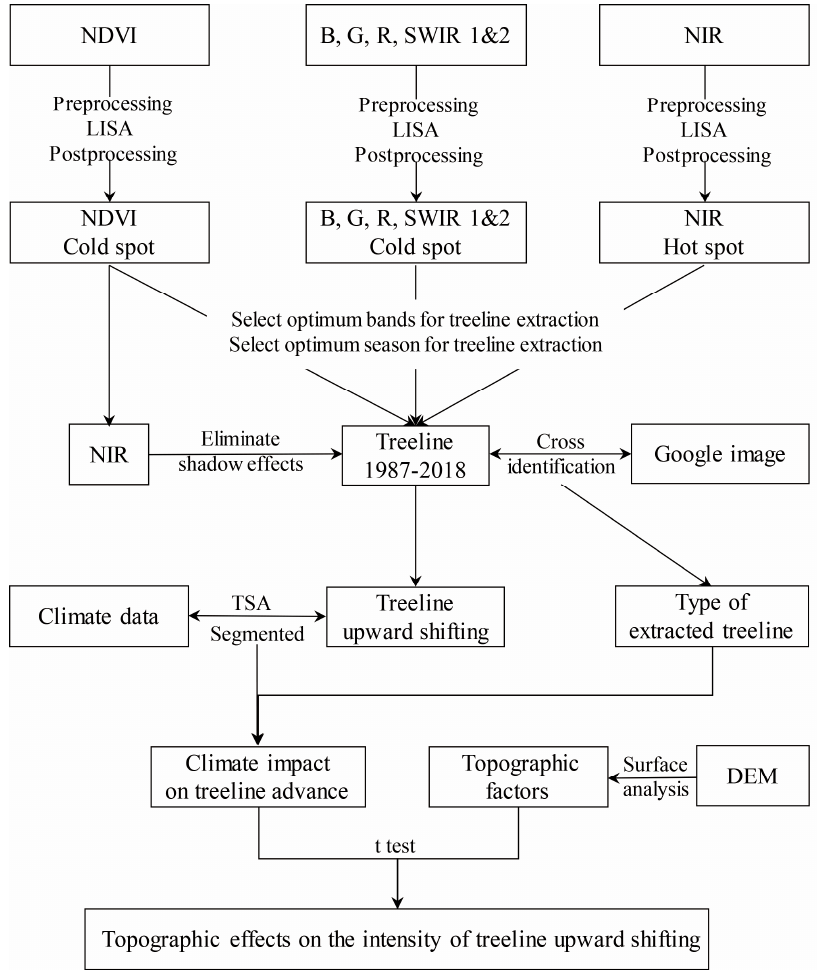
Figure 4. Methodology flowchart. TSA: time-series analysis; segmented: segmented linear regression; NDVI: normalized difference vegetation index; B: blue band; G: green band; R: red band; NIR: near-infrared band; SWIR 1 and 2: first and second shortwave infrared bands; DEM: digital elevation model image with a 30 × 30 m spatial resolution. Cold spot: low values significantly clustered together spatially; hot spot: high values significantly clustered together spatially.